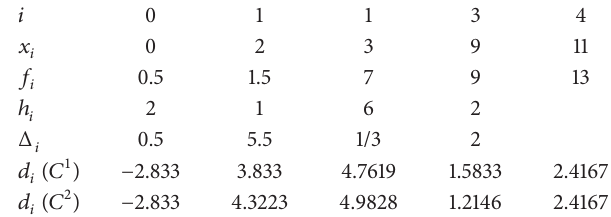
Table 1: A data from work by Sarfraz et al.